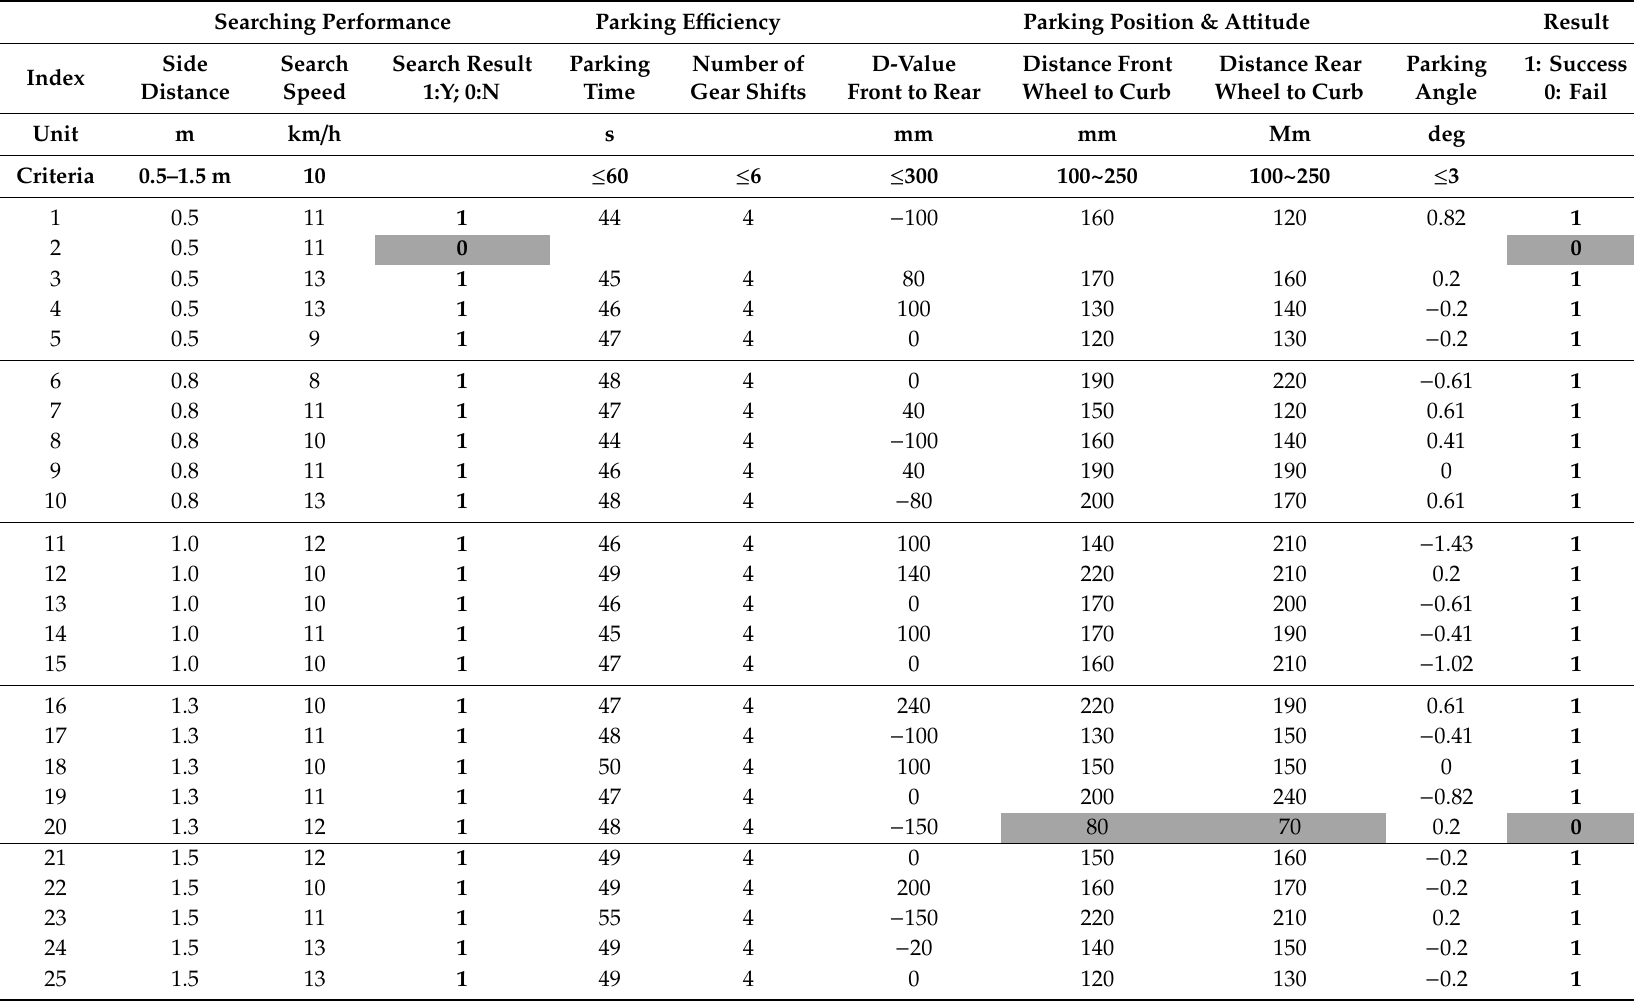
Table 2. Automatic Parking Test Data of Standard Parking